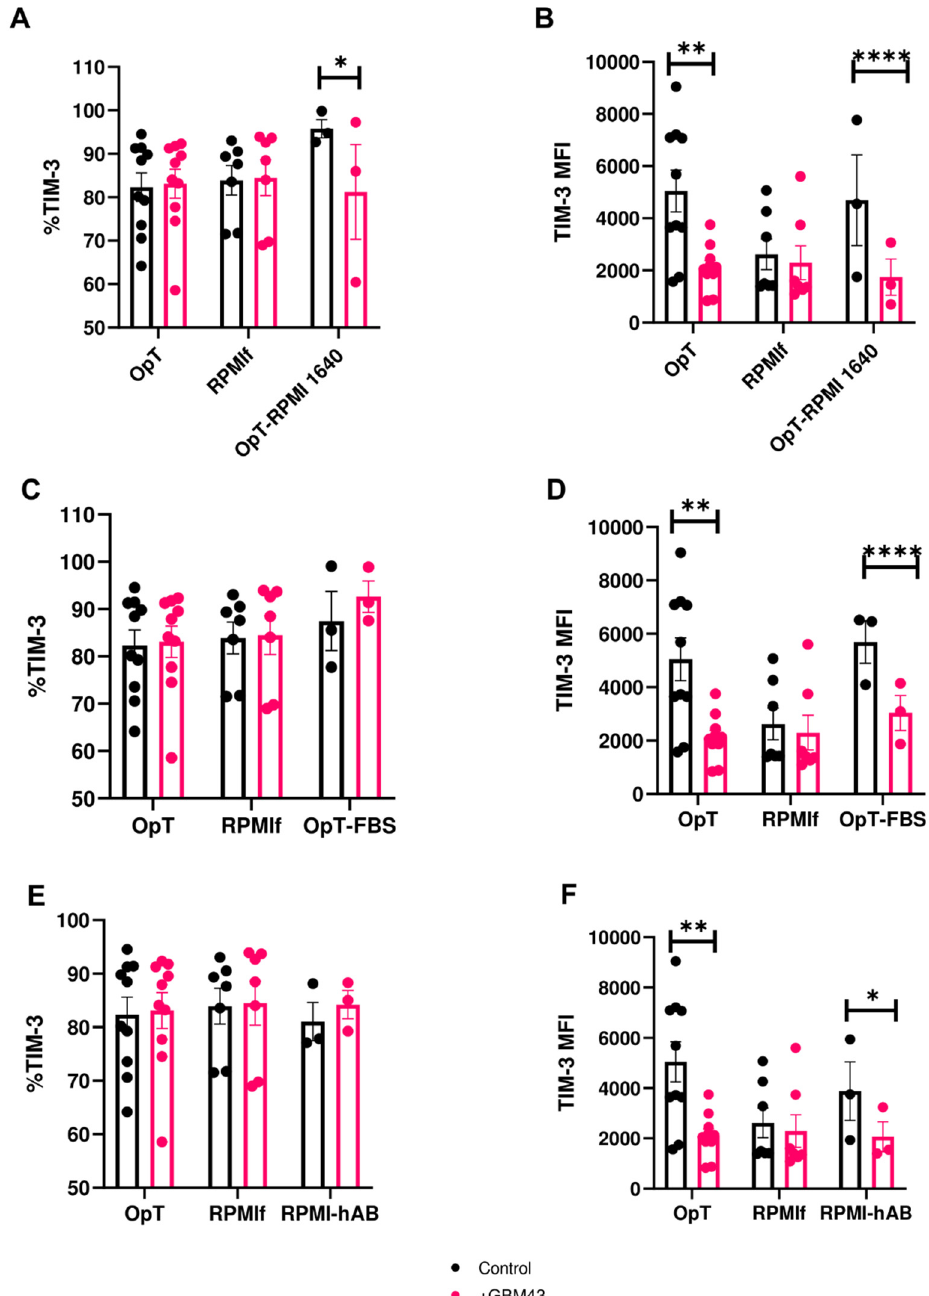
Figure 4. Expression of TIM-3 on NK cells in response to cancer cells under varying media and serum compositions (mean ± SEM). Percentage and MFI of TIM-3 were measured on human NK cells after 4 h co-culture with GBM43 cells at an E:T ratio of 2.5:1 ( n = 3–10 donors). ( A , B ) TIM-3 expression on NK cells expanded in OpT ( n = 10), RPMIf ( n = 7) or OpT with RPMI-1640 as the basal medium component (OpT-RPMI 1640, n = 3); ( C , D ) TIM-3 expression on NK cells expanded in OpT, RPMIf or OpT with fetal bovine serum FBS instead of human AB serum ( n = 3); ( E , F ) TIM-3 expression on NK cells expanded in OpT, RPMIf, or RPMIf with human AB serum instead of FBS ( n = 3). * p < 0.05, ** p < 0.01, **** p < 0.0001.